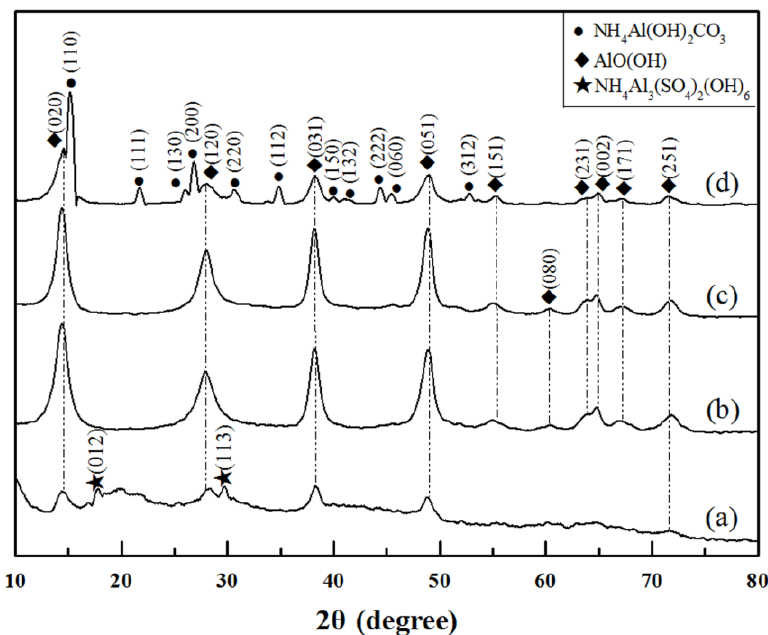
Figure 1. X-ray diffraction (XRD) patterns of deposited precursors fabricated by hydrothermal method under different molar ratio of Al 3+ :CO(NH 2 ) 2 : ( a ) 1:3, ( b ) 1:5, ( c ) 1:6 and ( d ) 1:7.